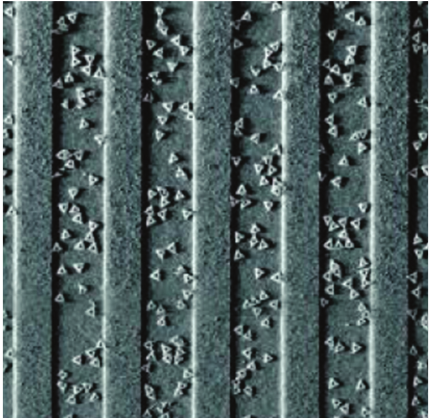
Figure 10: IBM tiny circuit boards